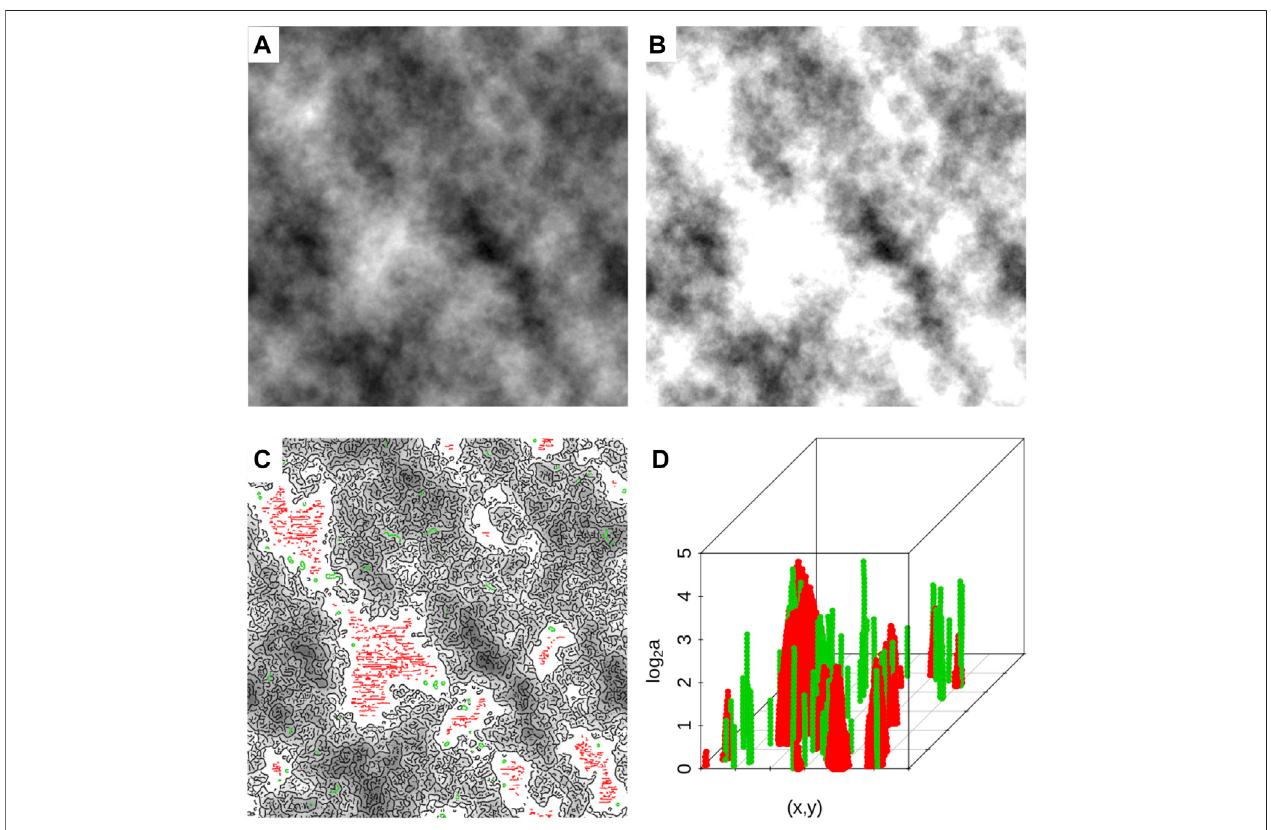
FIGURE8|(A) Asample fBmsurfacewith H =0.7. (B) The same surfaceasin (A) butsaturated at20%. (C) Thesaturatedsurface overlaidwithmaxima chains (at scale 20 pixels) that were kept (black), those that were eliminated by applying the modulus fi lter log 2 ( MF ) = 4 (red), and those eliminated by applying the slope fi lter SF = 0.5 (green). (D) The corresponding extraneous maxima lines that were